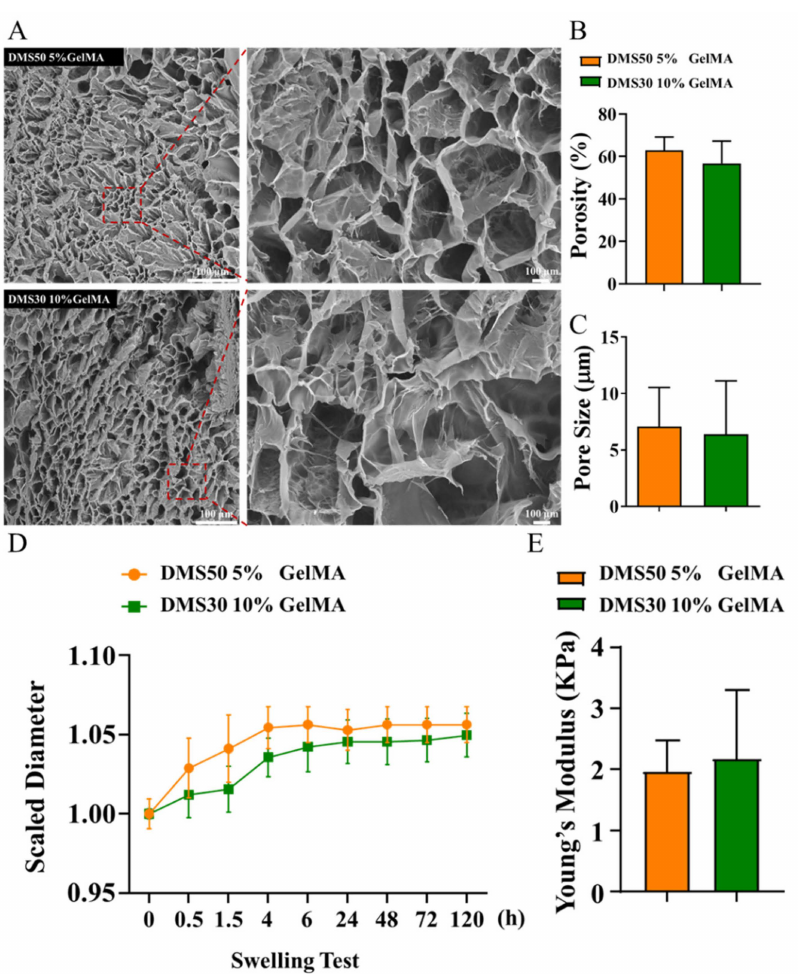
Figure 1. Material characterization. ( A ) The surface strucures GelMA, ( B ) Pore size of GelMA, ( C ) Porosity of GelMA, ( D ) Swelling test for GelMA, ( E ) Young’s modulus for GelMA under com- pression